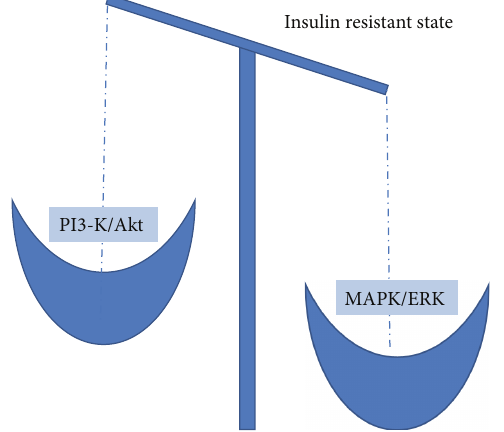
Figure 2: Conceptual definition of insulin resistance at molecular